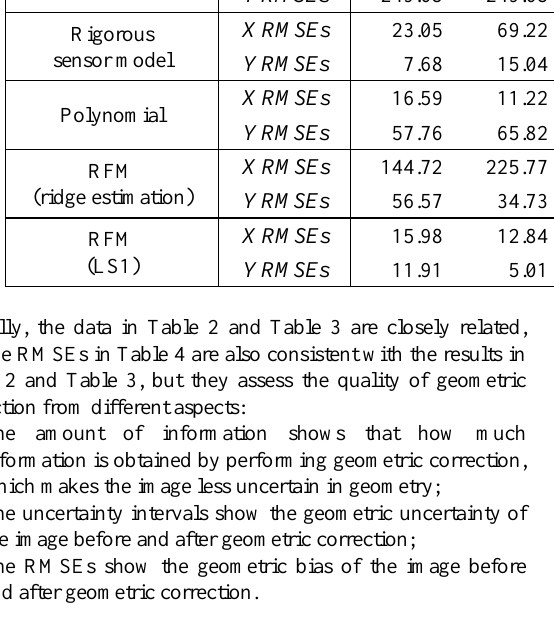
Table 4. The root mean square errors (RMSE) before and after geometric correction using four approaches in seven situations (Unit: meter) a b Before